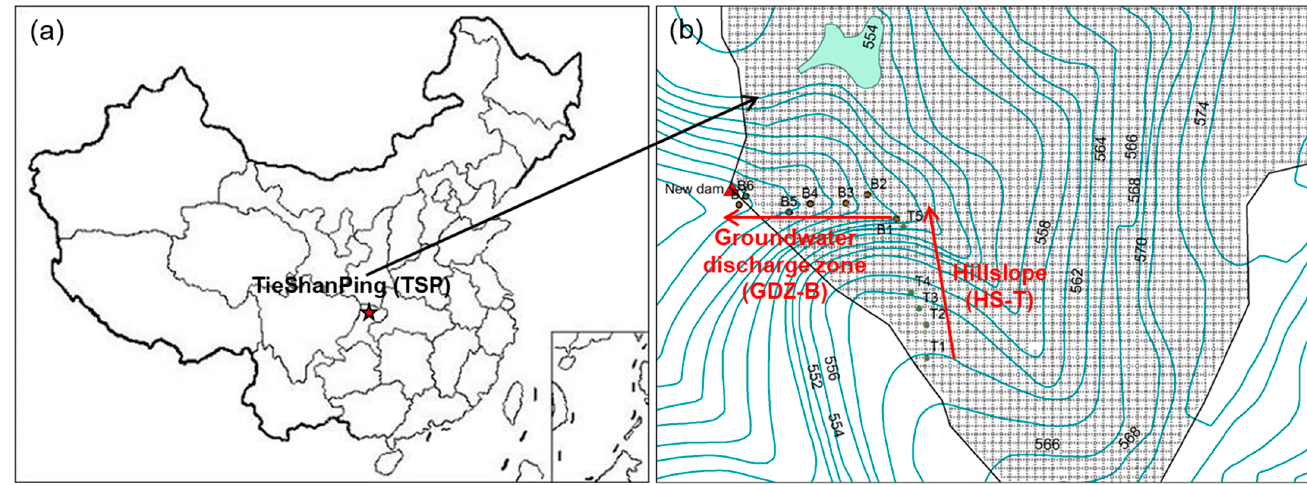
Figure 1. ( a ) The TieShanPing (TSP) forest catchment, Chongqing, China and ( b ) plot layout along two transects following the hydrological flow path on hillslope (HS-T0 to HS-T5) and the groundwater discharge zone (GDZ-B1 to GDZ-B6). Adapted from Zhu et al. (2013) [12].